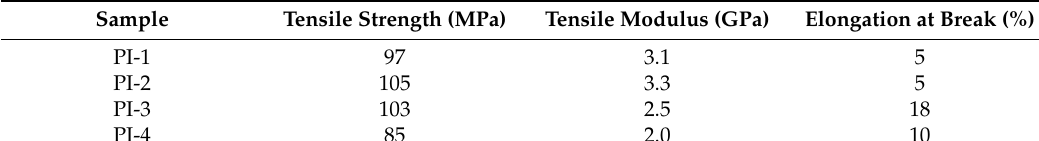
Figure 11. The melt viscosities as a function of time for polyimides: ( a ) PI-1; ( b ) PI-2. Table 4. Mechanical properties of polyimides.